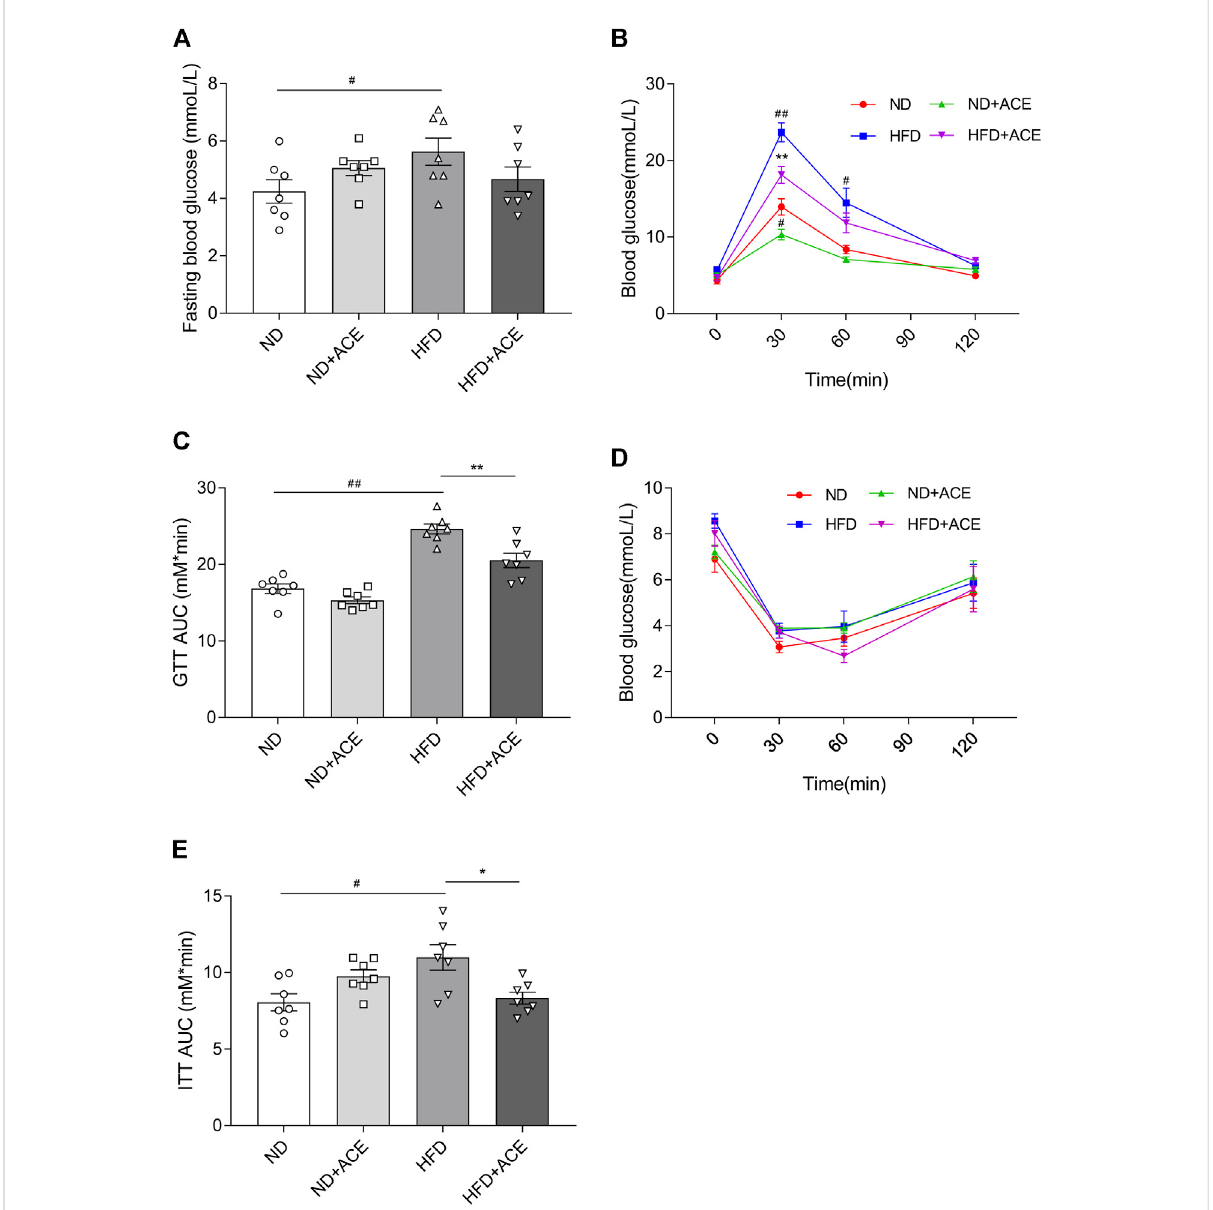
FIGURE 3 ACE ameliorated HFD-induced glucose intolerance and insulin resistance. (A) Fasting blood glucose levels. (B – C) Glucose tolerance of mice. (D – E) Insulin tolerance of mice. Data were shown as means ± S.E.M (n = 7 per group). Glucose tolerance test and insulin resistance test were measuredat0,30,60and120 minandstatisticalanalysiswasperformedusingtwo-wayanalysisofvariance.Statisticalanalysisoftheareaunderthe curve (AUC) was conducted by using an independent student- t test. # denotes p < 0.05 when compared with the ND group, ## denotes p < 0.01 when compared with the ND group; * denotes p < 0.05 when compared with the HFD group, ** denotes p < 0.01 when compared with the HFD